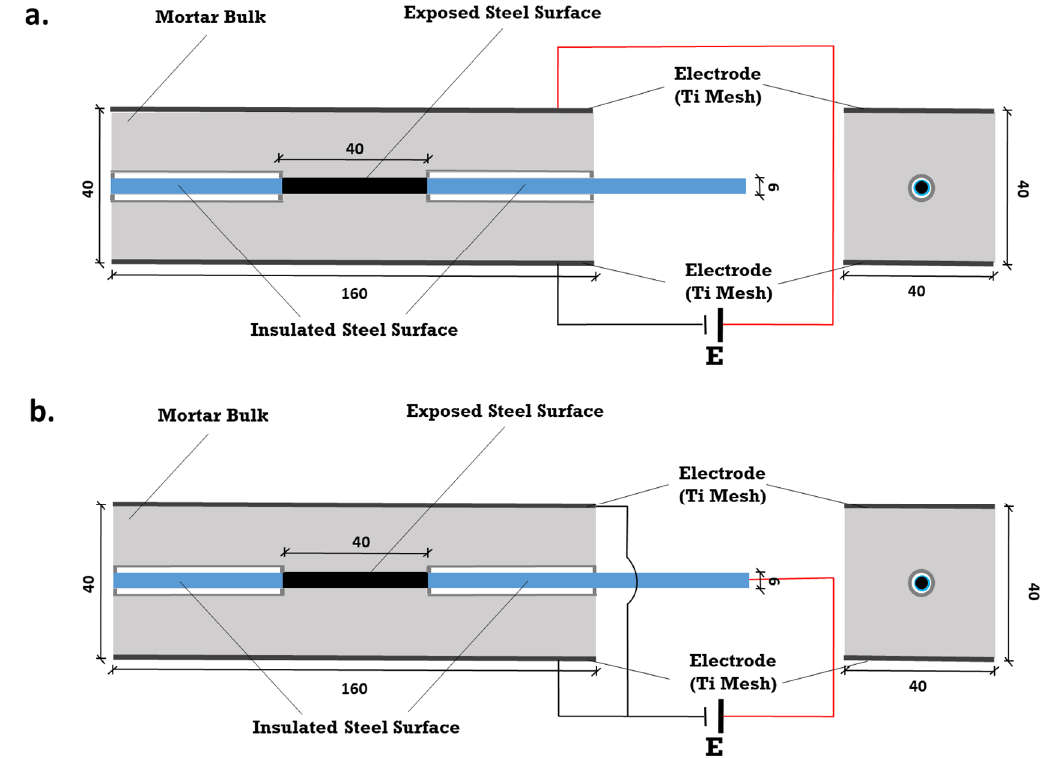
Figure 2. Experimental set-up for current supply and position of electrodes: ( a ) Stray current; ( b ) Anodic polarization.